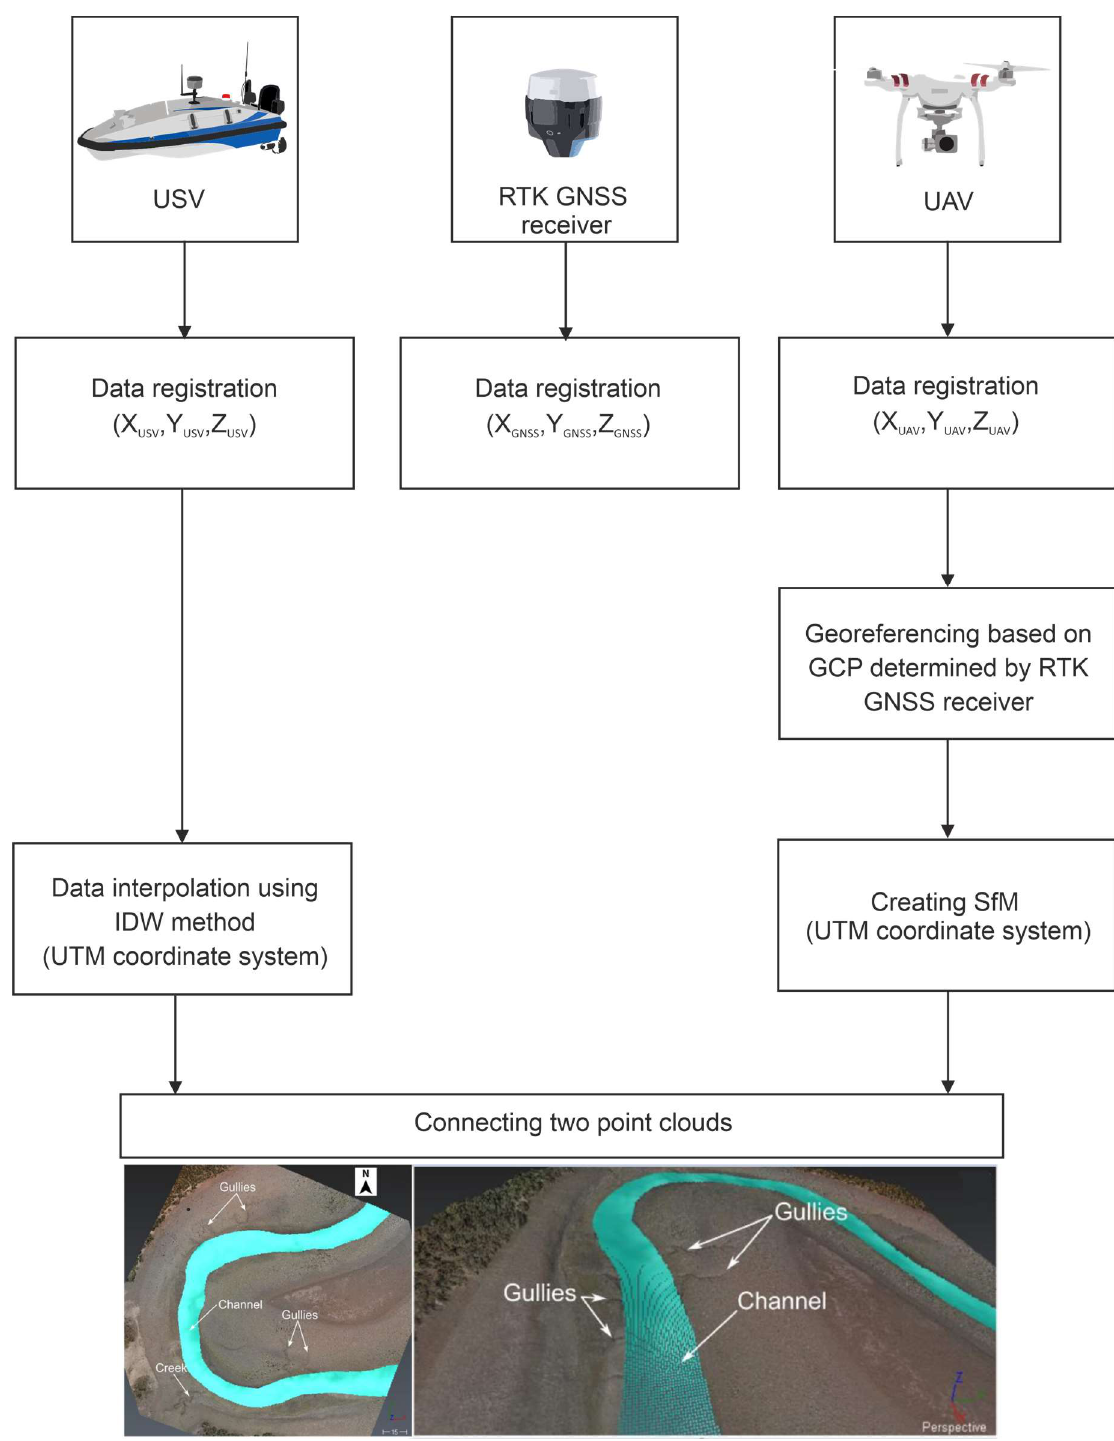
Figure 4 Figure 4. A simplified block diagram presenting the UAV and USV data integration according to [30]. One of the aims of the study was to generate a topographical terrain model that covers the river mouth area using the Structure from Motion (SfM) method [32]. This involved the creation of a three-dimensional model from a set of photographs, based on the observation and description of the location of points on the basis of a change in the perspective, i.e., the location of camera positions. To this end, a photogrammetric pass was conducted using a DJI Phantom 3 standard quadcopter. When planning the pass in the